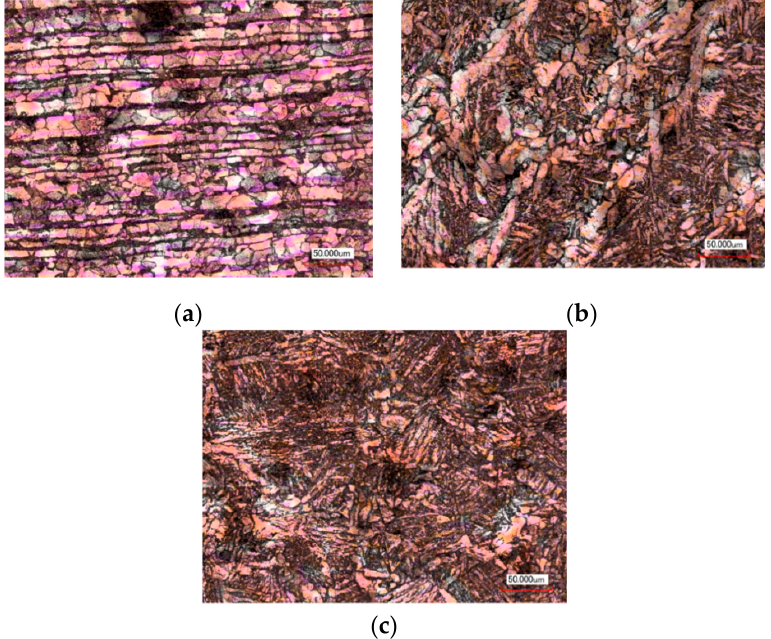
Figure 1. Microstructures of a steel weld joint: ( a ) Steel specimen; ( b ) weld metal; and ( c ) the heat affected zone.